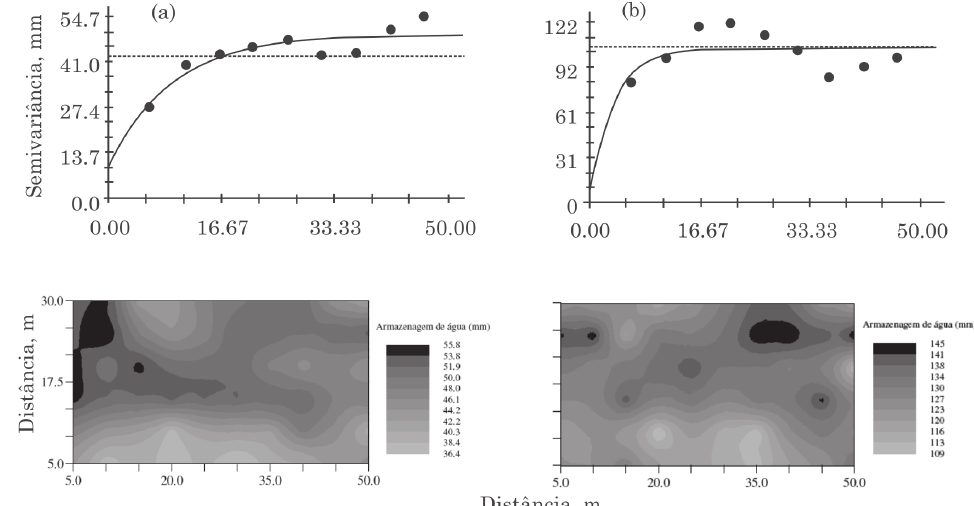
Figura 6. Semivariograma e mapa da armazenagem de água no solo nas camadas de 0-0,40 m (a) e 0-0,80 m (b) durante o ciclo do feijoeiro. Semivariogramas escolhidos de acordo com os parâmetros da validação cruzada. Períodos 6 e 8 para as camadas de 0,0-0,40 e 0,0-0,80 m,